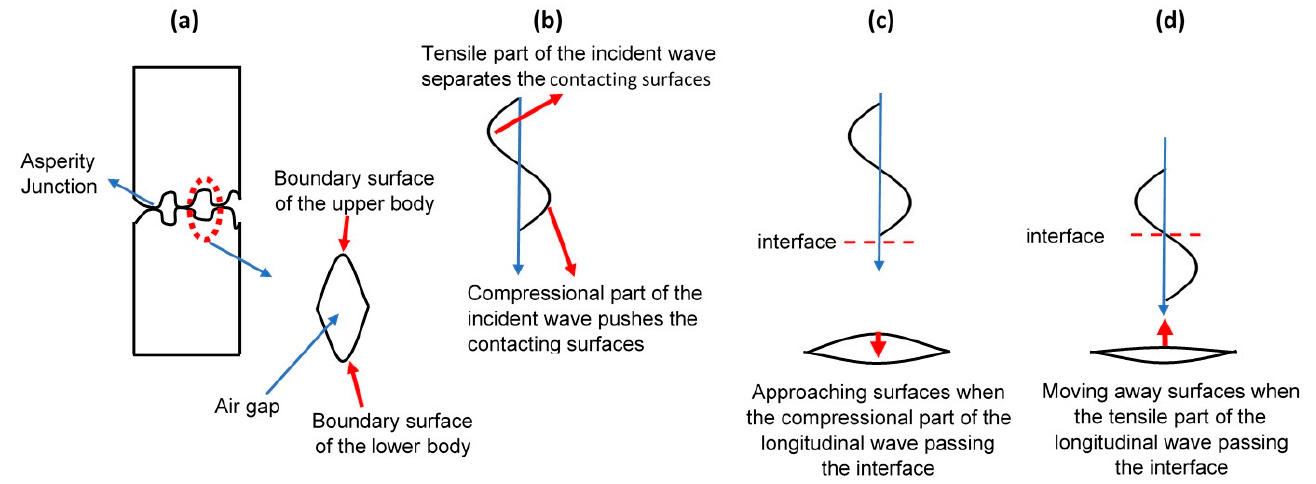
Figure 2. Schematic diagram of higher harmonic generation at an incomplete interface [41]: ( a ) rough surface interface mod- elled as array of gaps; ( b ) incidents ultrasonic wave interacts with the interface; ( c ) approaching surfaces; ( d ) being apart surfaces.